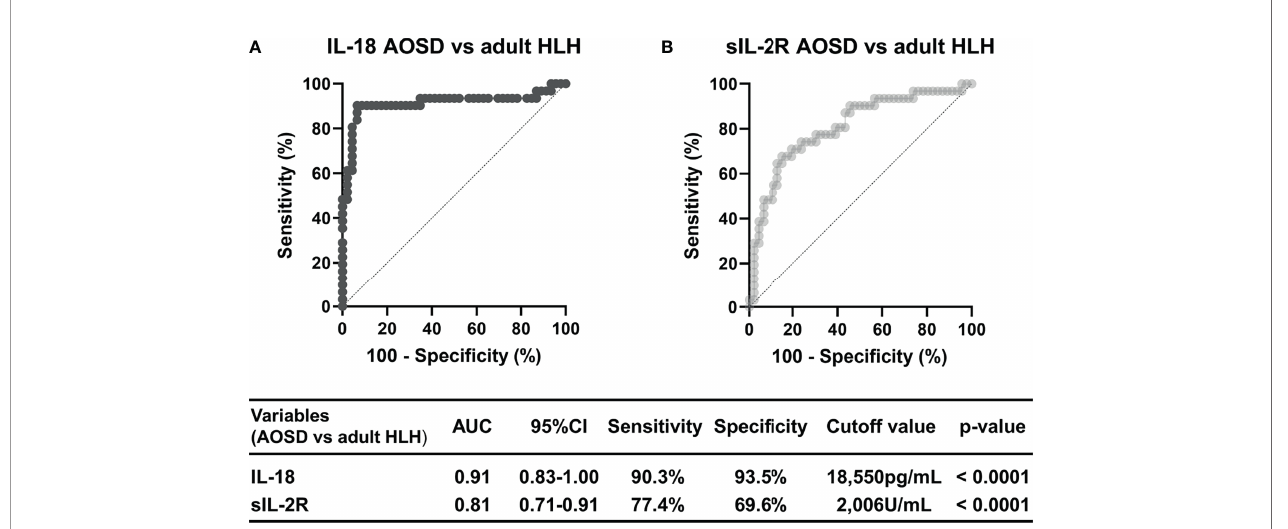
FIGURE 2 | The ROC curve analysis for the differential diagnosis of AOSD and adult HLH based on the serum levels of IL-18 and sIL-2R. The predictive performance of the serum levels of (A) IL-18 and (B) sIL-2R was validated by the ROC analysis, and the accuracy of differential diagnosis is indicated by the AUC and